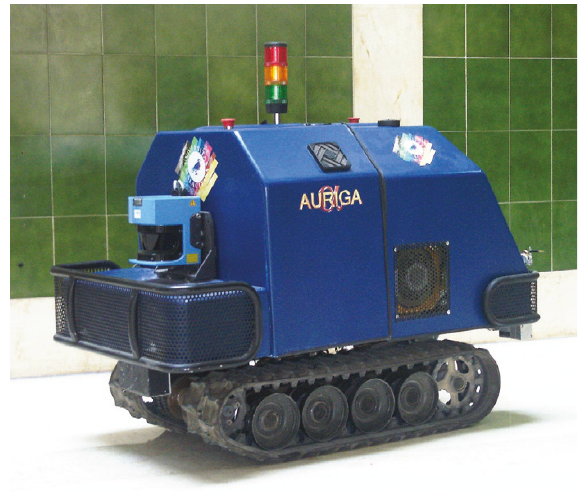
Figure 9: The tracked mobile robot Auriga- α